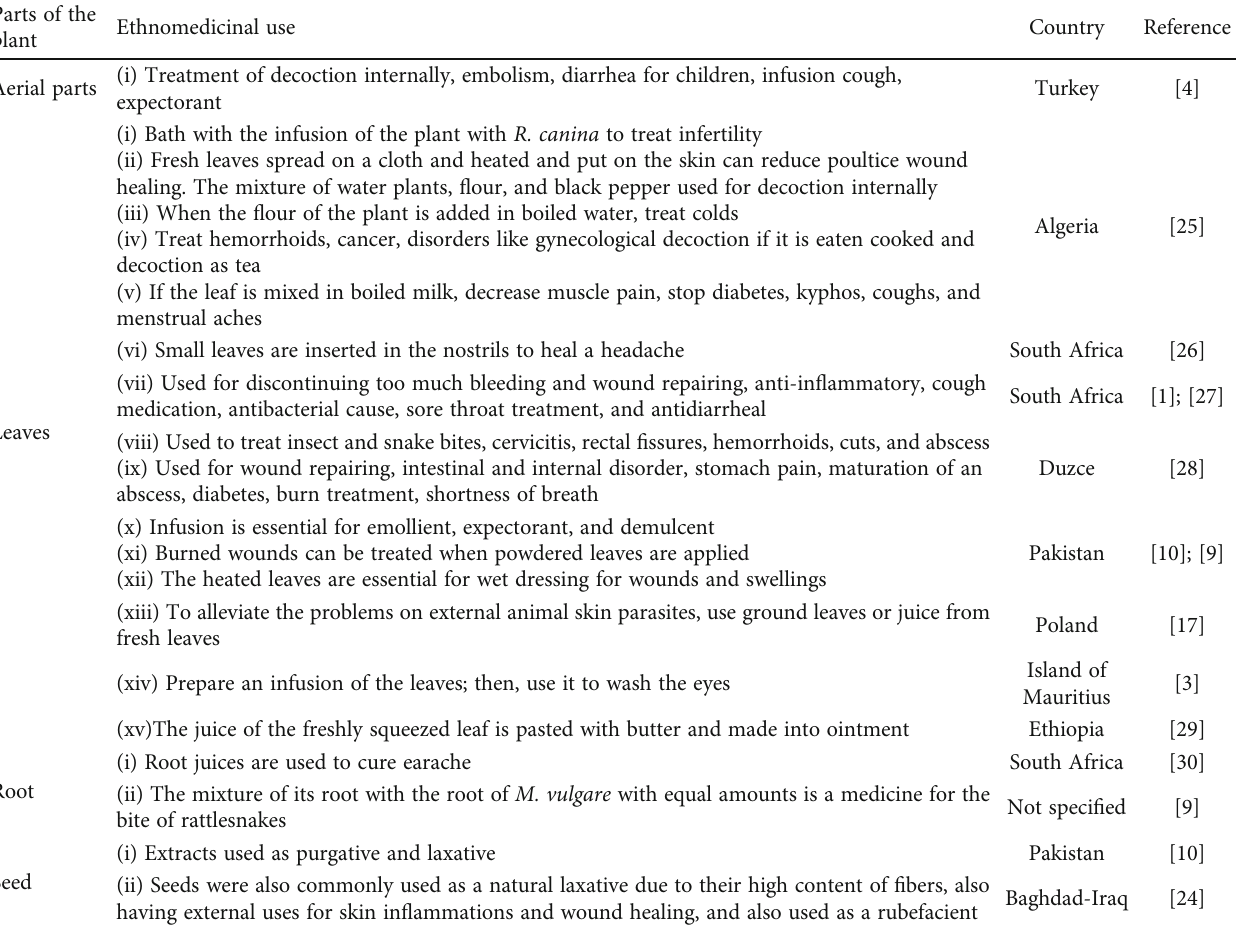
Table 1: Ethnomedicinal use of P. lanceolata